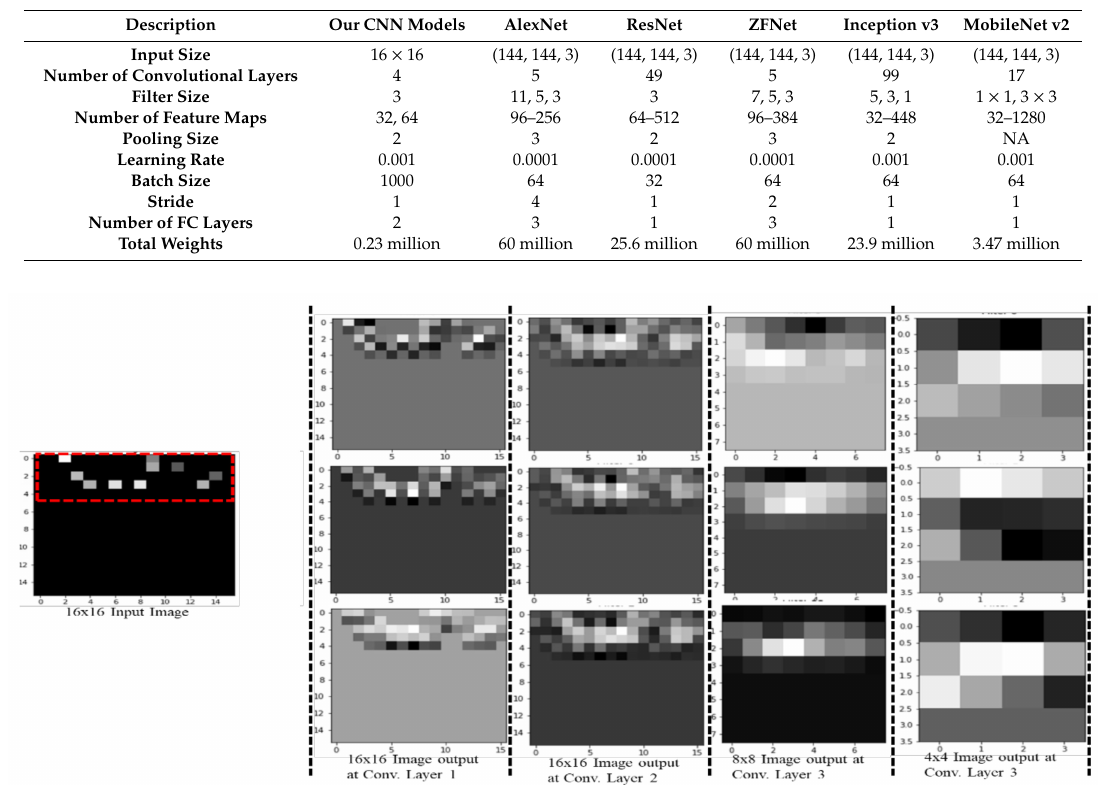
Figure 2. Proposed convolutional neural network (CNN) architecture for the indoor Wi-Fi positioning system in this study. Table 2. Hyperparameter description of CNN applications.